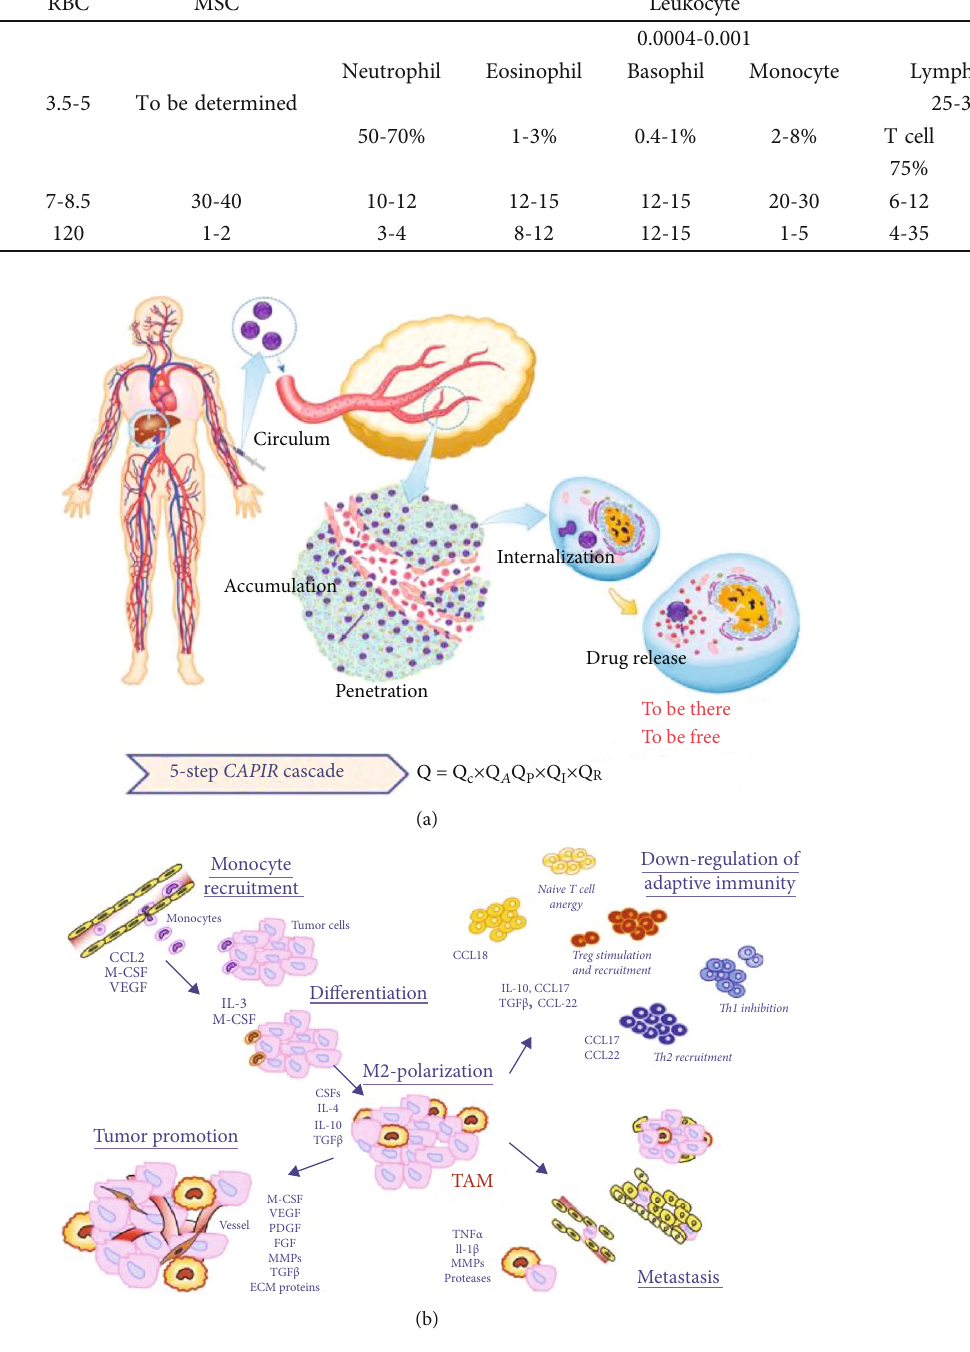
Figure 1: (a) Scheme of the CAPIR cascade of a nanomedicine to deliver a free drug into cancer cells. The overall e ffi ciency, Q , is the product of the e ffi ciencies of fi ve steps. Reproduced with permission [4]. Copyright 2017. John Wiley and Sons. (b) Overview of molecules that can recruit monocytes/macrophages to tumor sites and turn into tumor-associated macrophages. Reproduced with permission [26]. Copyright 2009. John Wiley and